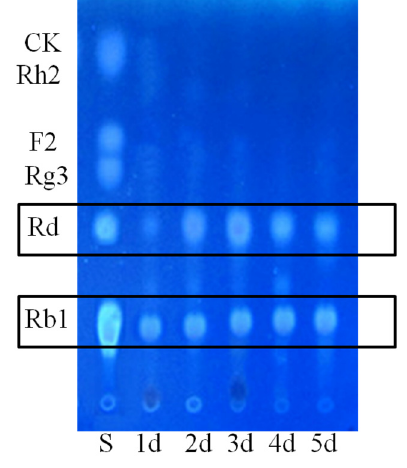
Figure 2. Influences of different substrate-feeding time on the biotransformation of